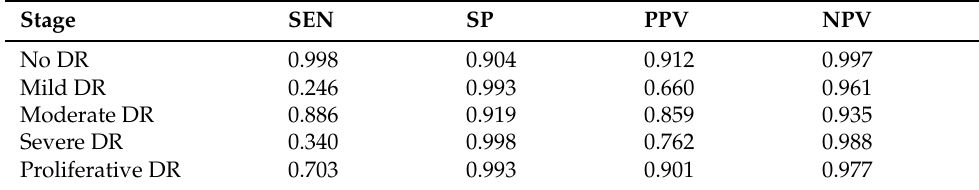
Table 13. The performance measures of the DR stages using CNN512 for the DDR dataset.